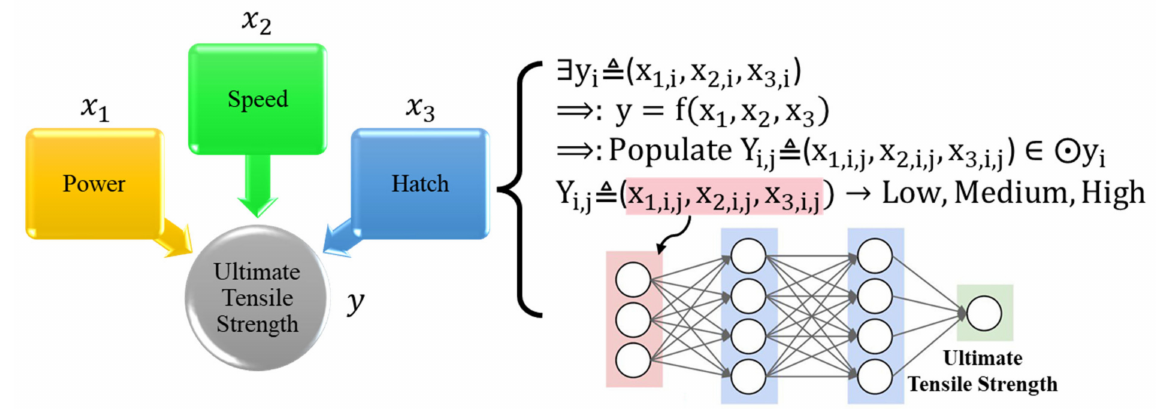
Figure 2. Process-Quality Framework Overall